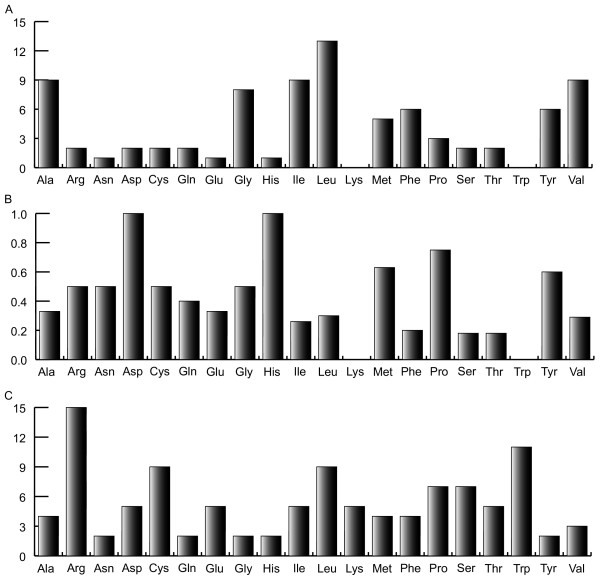
Frequencies of amino acids lost and gained through missense mutations of the CFTR protein. A, Observed frequencies of native CFTR amino acids lost through phenotypic missense mutations. B, Same as A but normalized for the particular frequencies of amino acids present in the membrane-spanning domains. C, Observed frequencies of non-native amino acids gained through phenotypic missense mutations from the CFTR mutation database.